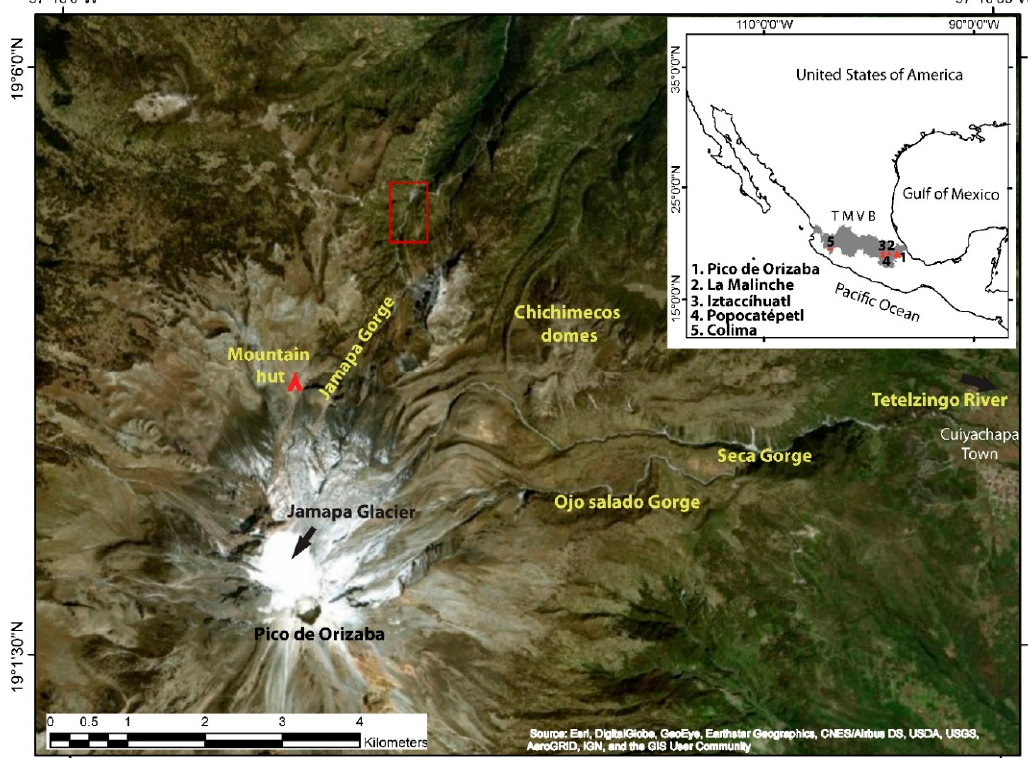
Figure 1. The Pico de Orizaba volcano is located in the eastern sector of the Trans ‐ Mexican Volcanic Belt (TMVB). Satellite imagery illustrating the volcano as well as the gorges mentioned. The Jamapa Gorge, where this study was realized, is located on the northern slope of the volcano. The study site is indicated with a red box.